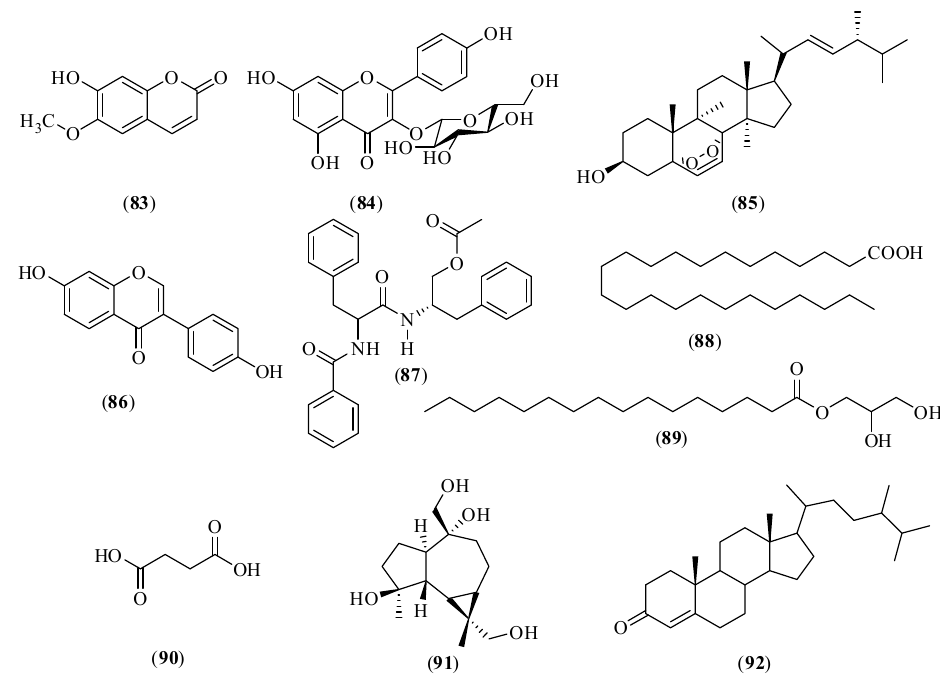
Figure 5. Chemical structures of other compounds in CX: ( 83 ) scopoletin; ( 84 ) astragalin; ( 85 ) ergosterol peroxide; ( 86 ) daidzein; ( 87 ) aurantiamide acetate; ( 88 ) lignoceric acid; ( 89 ) monopalmitin; ( 90 ) succinic acid; ( 91 ) ( − )-alloaromadendrane-4 β ,10 α ,13,15-tetrol; ( 92 )